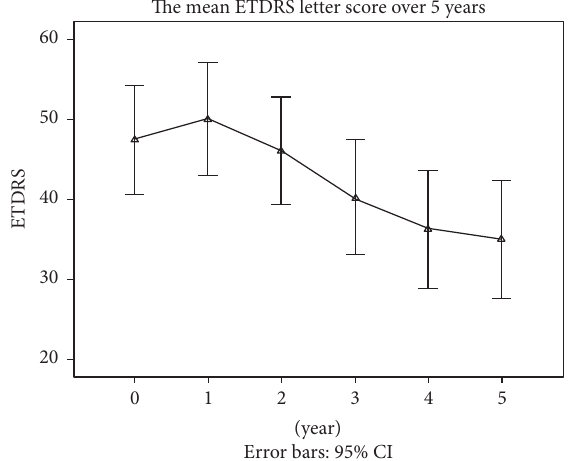
Figure 2: The mean BCVAs examined by the ETDRS chart at baseline and at every year after treatment.